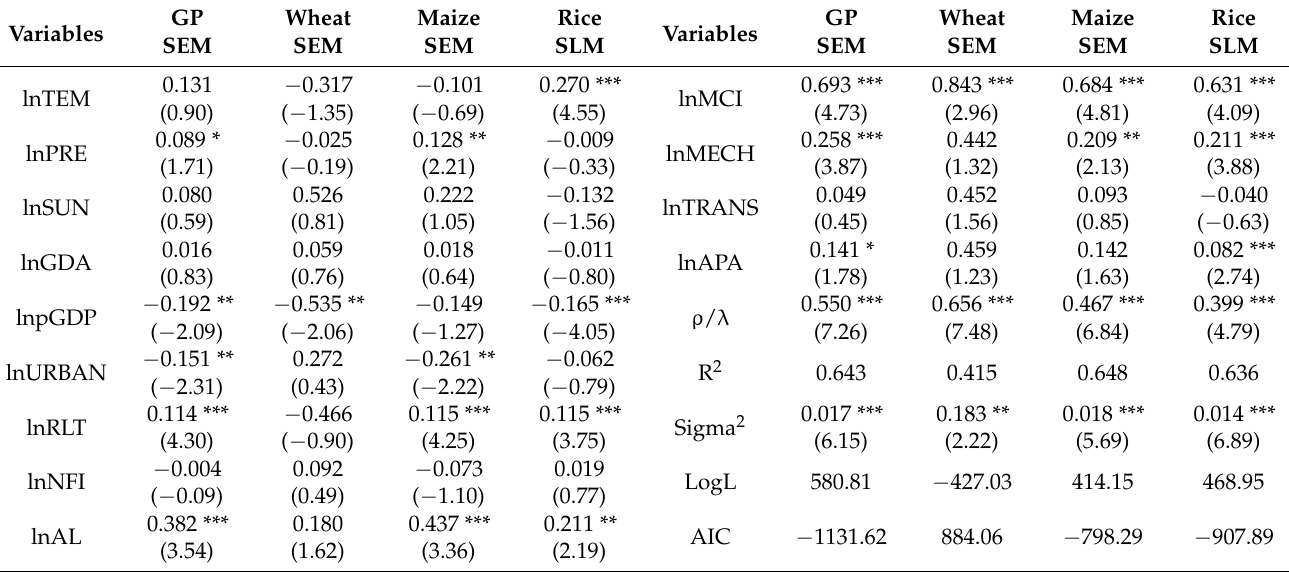
Table 2. Spatial econometric estimates of driving factors at the national